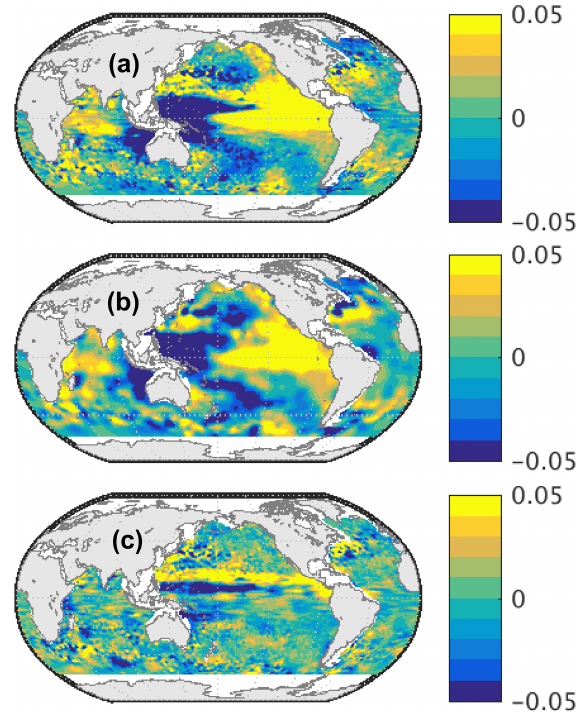
Figure 5. (a) Spatial pattern of nonseasonal anomalous Argo steric sea level (relative to 2005–2015 with linear trends and annual cy- cles removed) computed from the SIO gridded dataset over the last 6 months (July–December) of 2015. (b) As in (a) but computed from the IPRC gridded dataset. (c) Spatial pattern of the difference between the two gridded datasets (i.e., SIO minus IPRC). All panels have units of cm steric sea